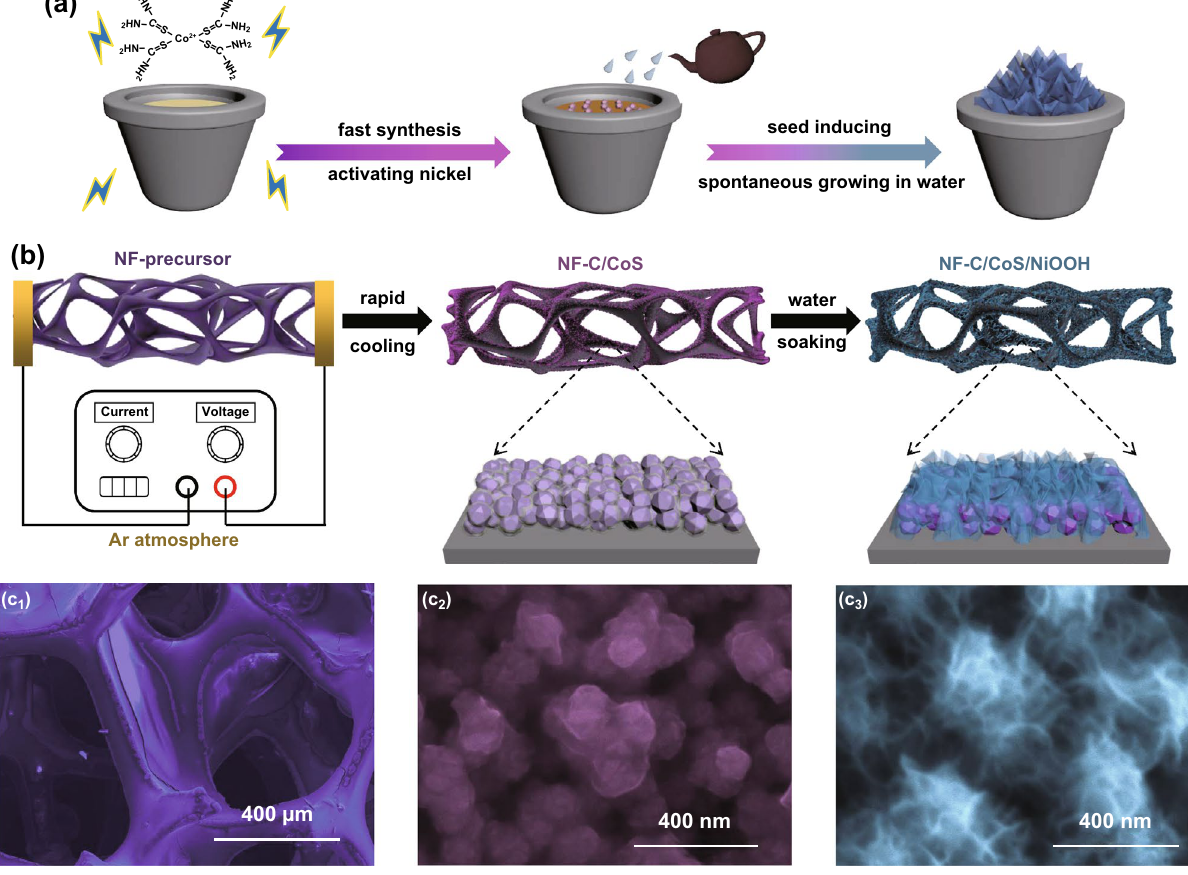
Fig. 1 a Synthesis strategy of NF-C/CoS/NiOOH. b Schematic illustration for preparation of NF-C/CoS/NiOOH. SEM of c 1 NF-precursor, c 2 NF-C/CoS and